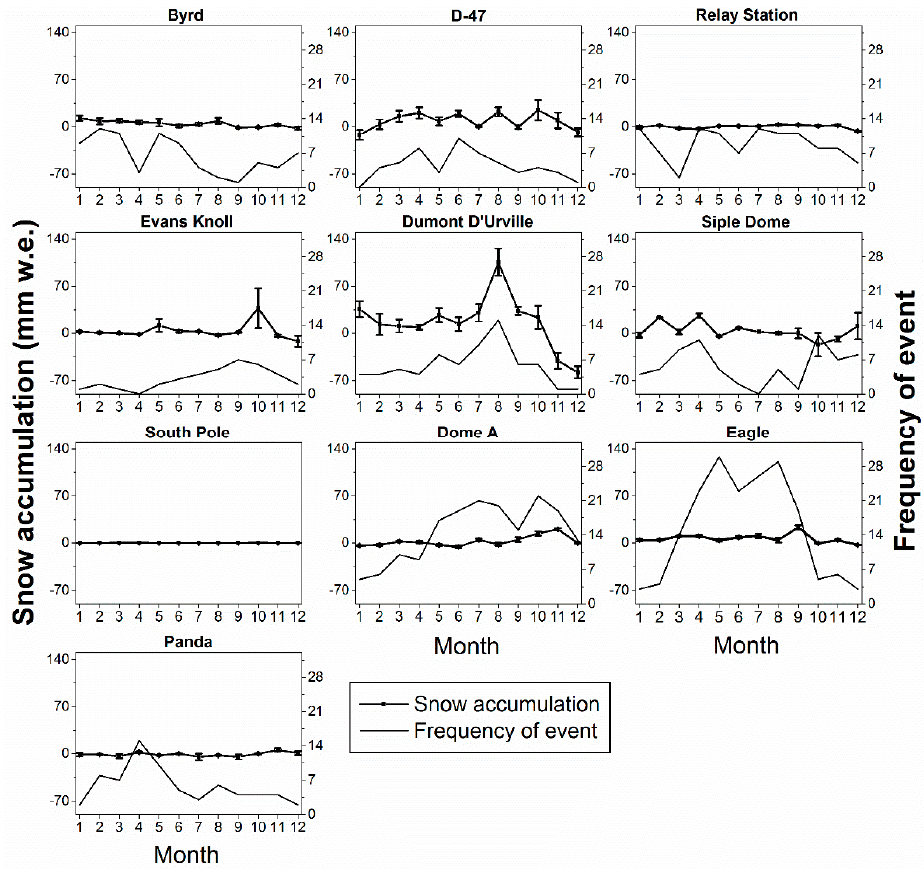
Figure 2. Seasonal variations in the annual average SMB at each station and the monthly frequencies of high accumulation events at nine stations. The left-hand axes show snow accumulation (mm w.e.) and the error bars denote the standard deviation of the mean values. The right-hand axes show the monthly frequencies of events.